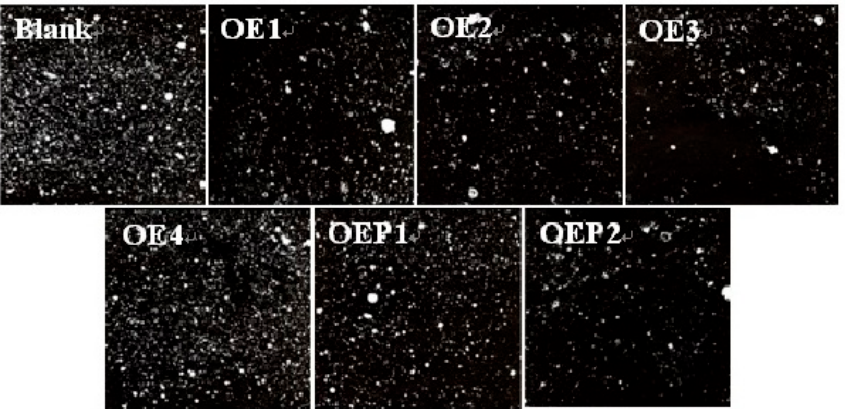
Figure 8. Air-void photographs of the hardened specimen samples mixed with various defoamers.